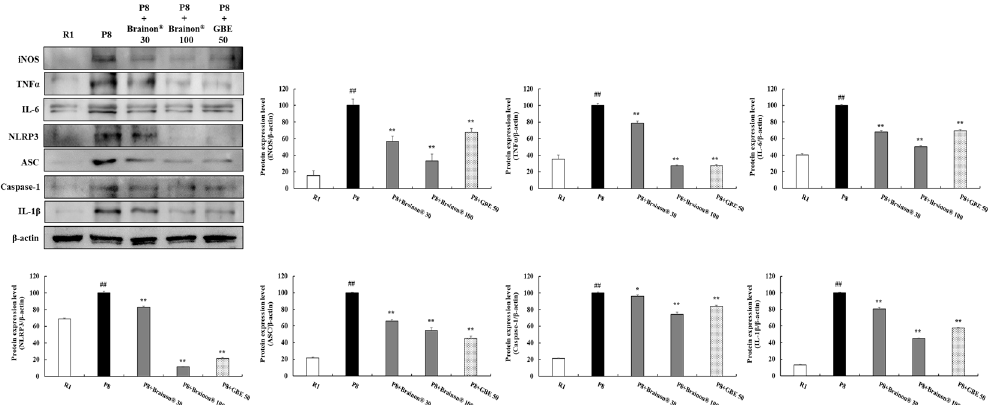
Figure 7. Brainon ® inhibits expression of inflammatory cytokines in the cerebral cortex of SAMP8 mice. iNOS (130 kDa), TNF α (25 kDa), IL-6 (17–25 kDa), NLRP3 (85–110 kDa), ASC (22 kDa), Caspase-1 (20–48 kDa), and IL-1 β (30 kDa) protein levels were assessed using Western blotting. The density of each protein band was measured using the ImageJ program. Protein was normalized with β -actin (45 kDa). Values are presented as mean ± SD ( n = 3). ## p < 0.01 vs. R1 (SAMR1) group; * p < 0.05 and ** p < 0.01 vs. P8 (SAMP8) group.